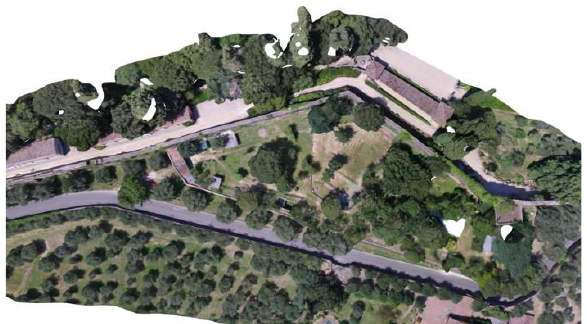
Figure 1. 3D surviving of the FI-MU